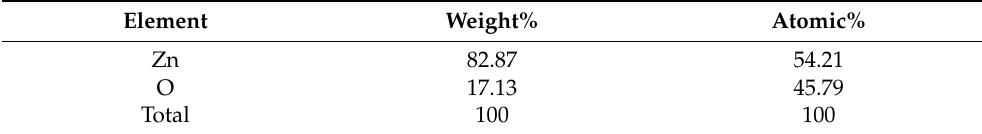
Table 1. Elemental Composition of